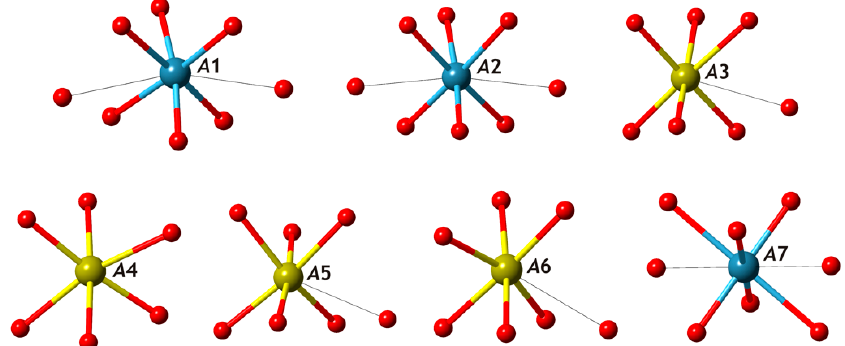
Figure 5. Coordination of the A -type cations in the crystal structure of chirvinskyite. The A -O bonds longer than 2.6 Å are shown as black single lines. Legend: Ca = blue, Na = yellow, and O = red.